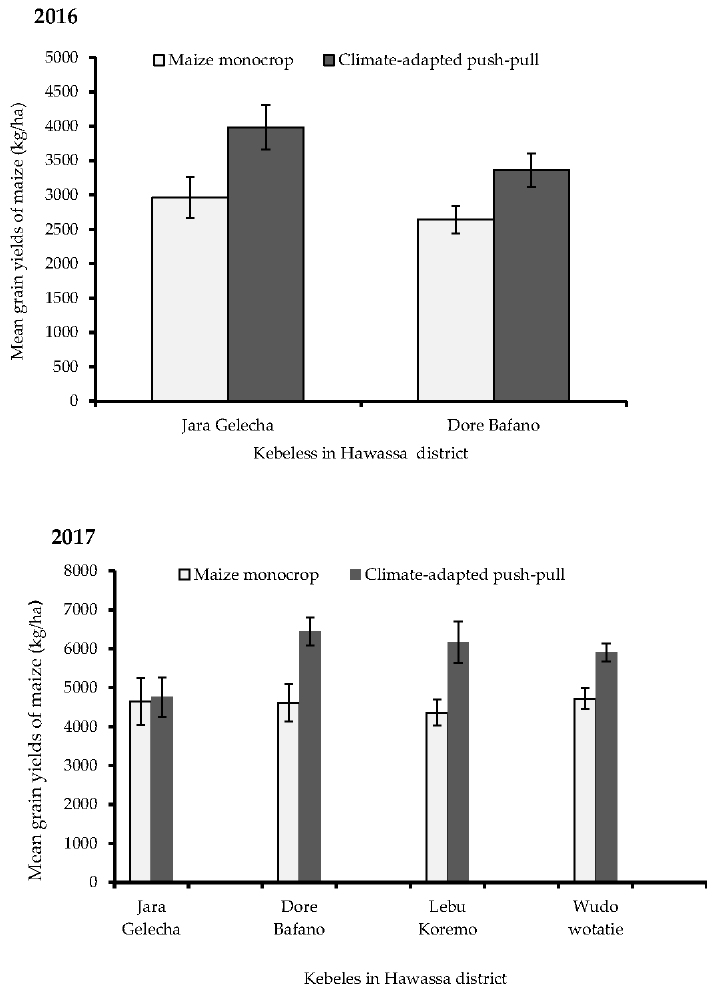
Figure 2. The mean (±S.E.) grain yields of maize (kg/ha) planted in the maize monocrop or climate- adapted push-pull stands in the Hawassa district in the 2016 and 2017 cropping